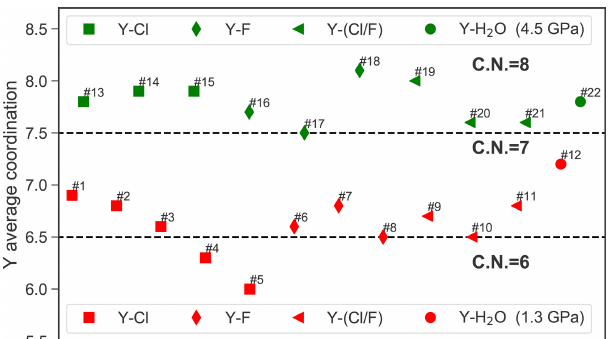
Figure 4. Average yttrium coordination by chloride, fluoride and oxygen for run #